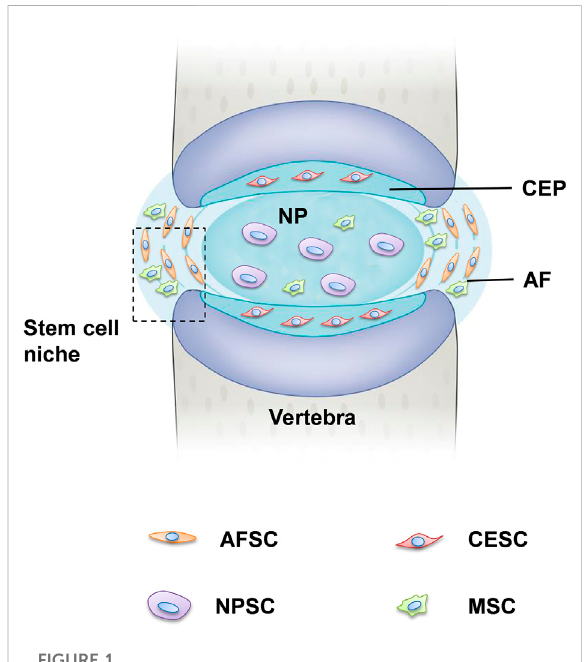
FIGURE 1 Tissue-speci fi c progenitor cells and the location of stem cell niche. The IVD is the fi brocartilaginous part of a three three- componentconstructthatconsistsofthenucleuspulposus(NP)in the center and annulus fi brosus (AF) in the surrounding, both of which are connected by cartilaginous endplates (CE). Progenitor cells have been found in all three constructs, respectively, referred to NPSCs, AFSCs, and CESCs. The perichondrium region adjacent to the epiphyseal plate and the AF border to the ligament zone has been suggested to be the IVD stem cell